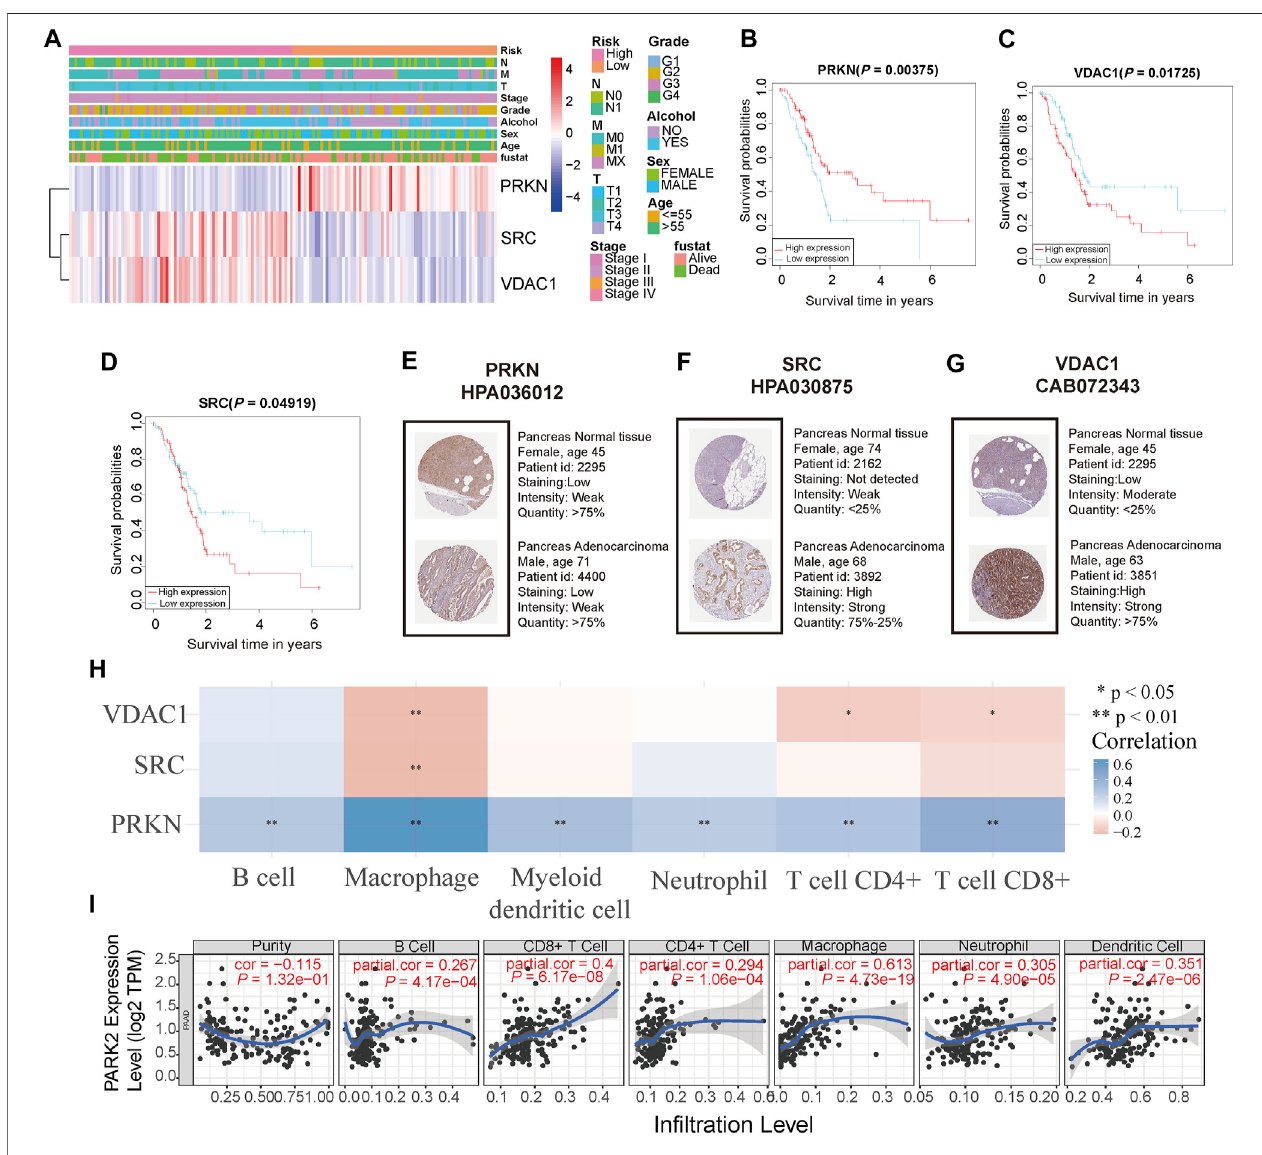
FIGURE 5 | Analyses of the three signature genes (A) Heatmap of the expression level of three signature genes and correlation between risk score and clinical featuresintheTCGAcohort (B,C,D) SurvivalanalysisofthreesignaturegenesintheTCGAcohort (E,F,G) Immunohistochemistrystainingofthreesignaturegenesinthe pancreas normal tissue and pancreas cancer tissue (H) The relationship between three signature genes and six immune cells. * represents p < 0.05; ** represents p < 0.01; *** represents p < 0.001 (I) PRKN correlates with tumor purity and is signi fi cantly positively associated with six immune in fi ltrates using the TIMER database.